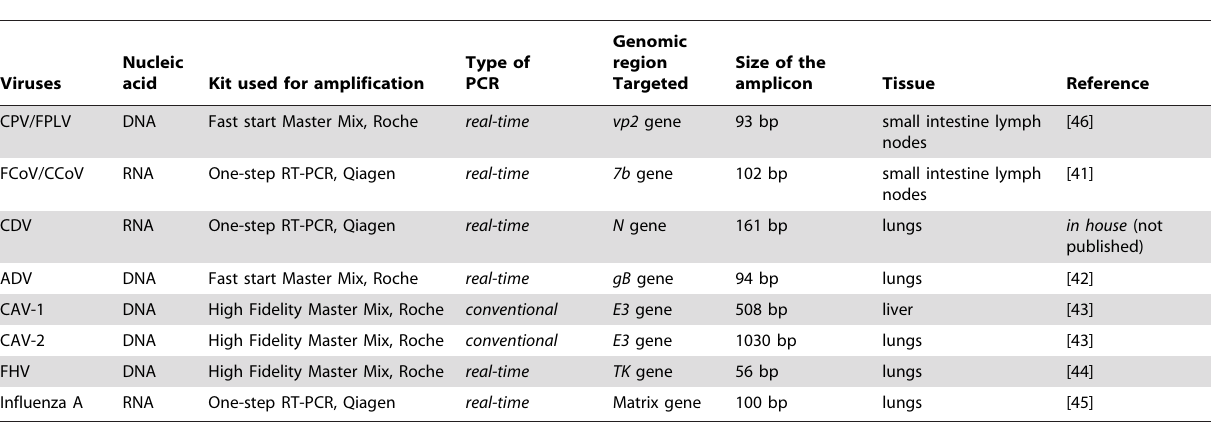
Table 2. Methods, tissues and genomic regions used for virus detection.